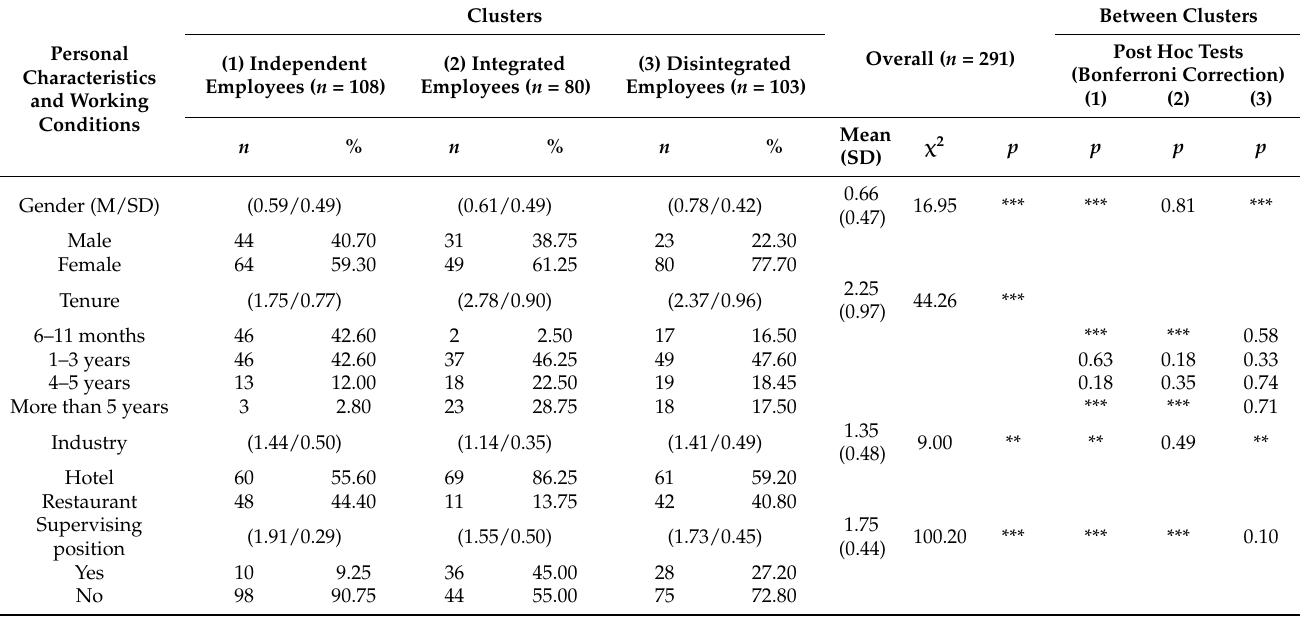
Table 4. Demographic profiles of the three clusters and their comparison.